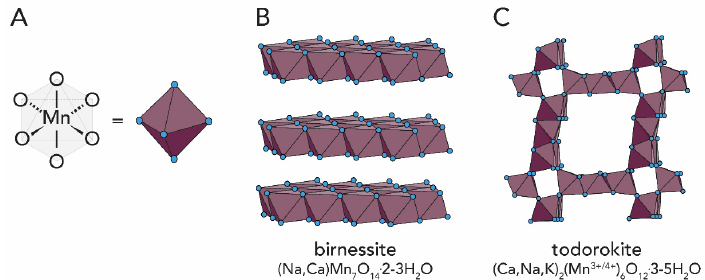
Figure 5. Examples of crystalline forms of manganese oxides in living nature. ( A ) Octahedral geometry of manganese. Representation of layered birnessite ( B ) and tunnel-type todorokite ( C ) structures. For clarity, only oxygen is shown (blue sphere), while Mn (not shown) is situated at the center of the octahedra.